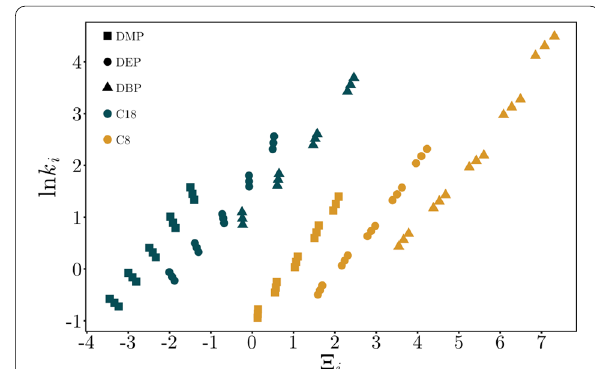
Fig. 1 Plot of experimental ln k i values for the training set